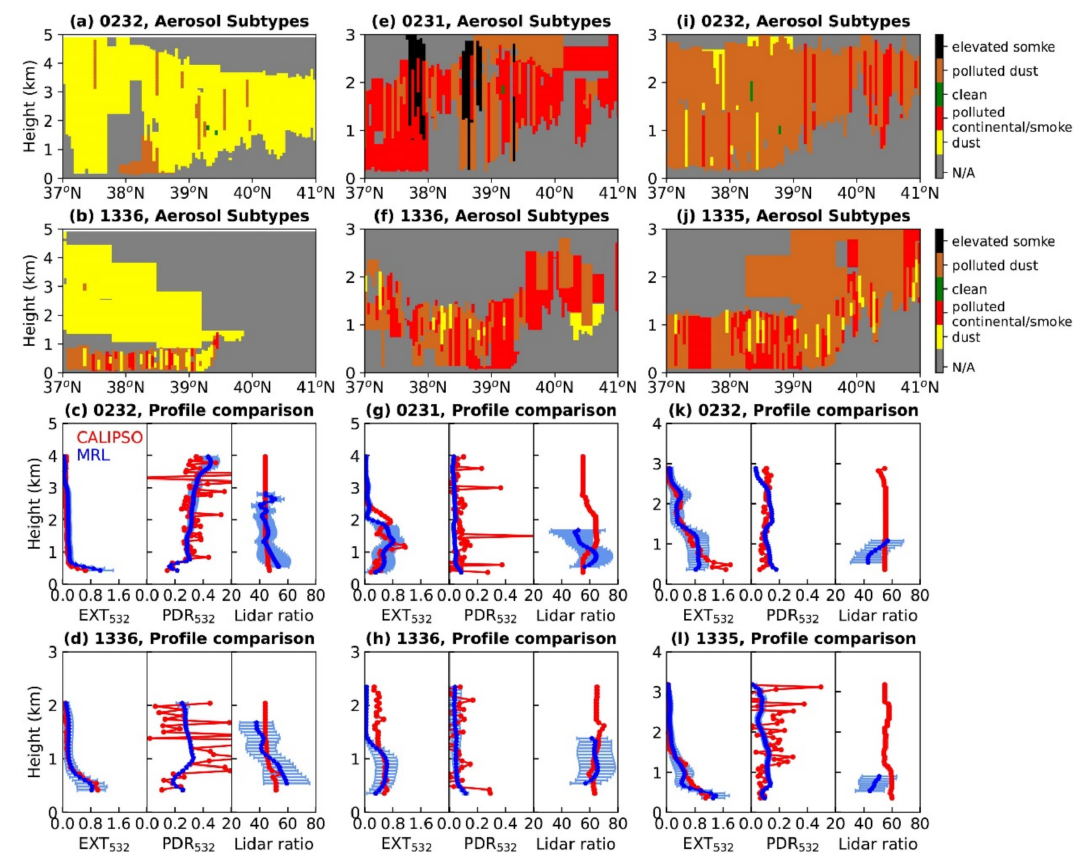
Figure 4. The CALIPSO observations compared with MRL. Latitude–height plots of the aerosol subtype mask and profile comparison of the EXT 532 , PDR 532 , and lidar ratio on ( a – d ) 1 April, ( e – h ) 6 July, and ( i – l ) 3 November. CALIPSO assumed LR 532 and MRL retrieves LR 355 . The envelopes in MRL profiles represent the errors at each altitude. The CALIPSO overpasses that occurred at a distance of less than 90 km and a temporal difference of less than 1 h were selected for profile